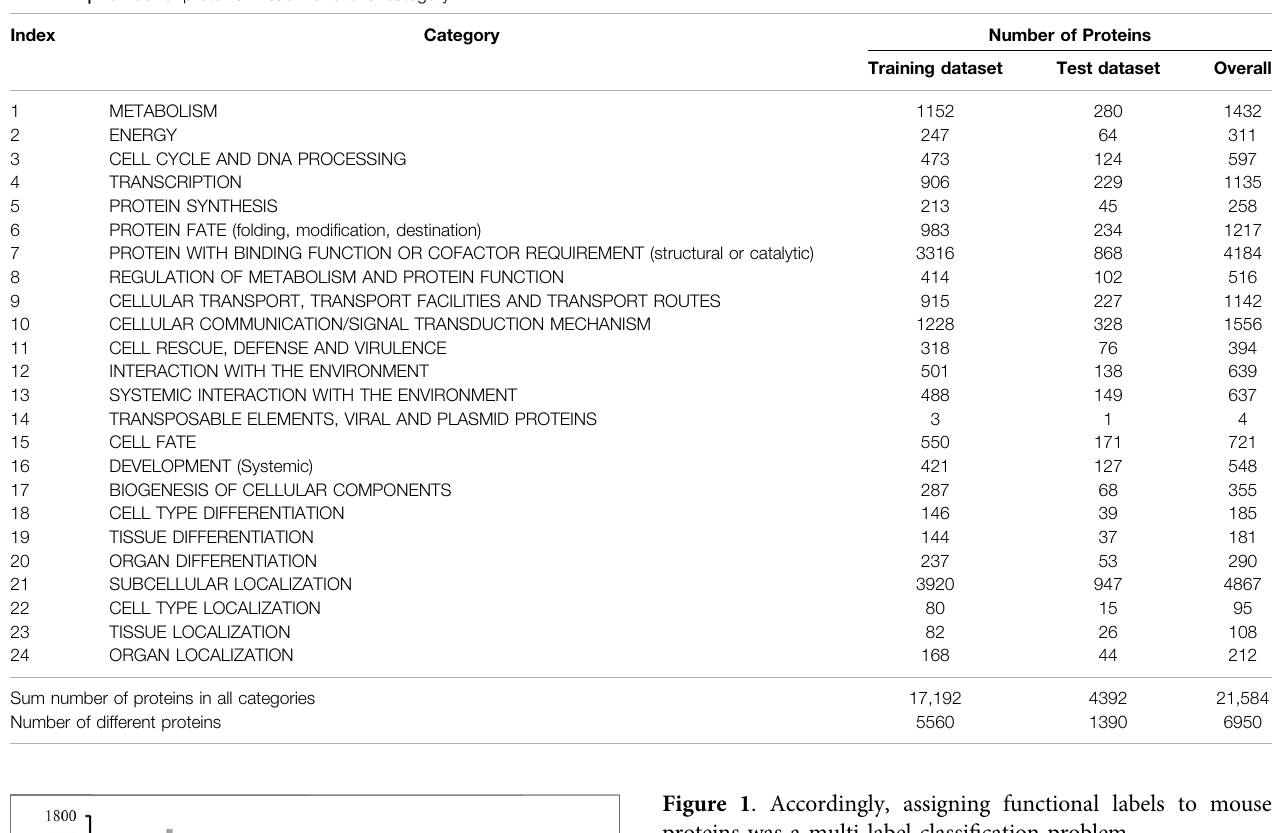
Figure 1 . Accordingly, assigning functional labels to mouse